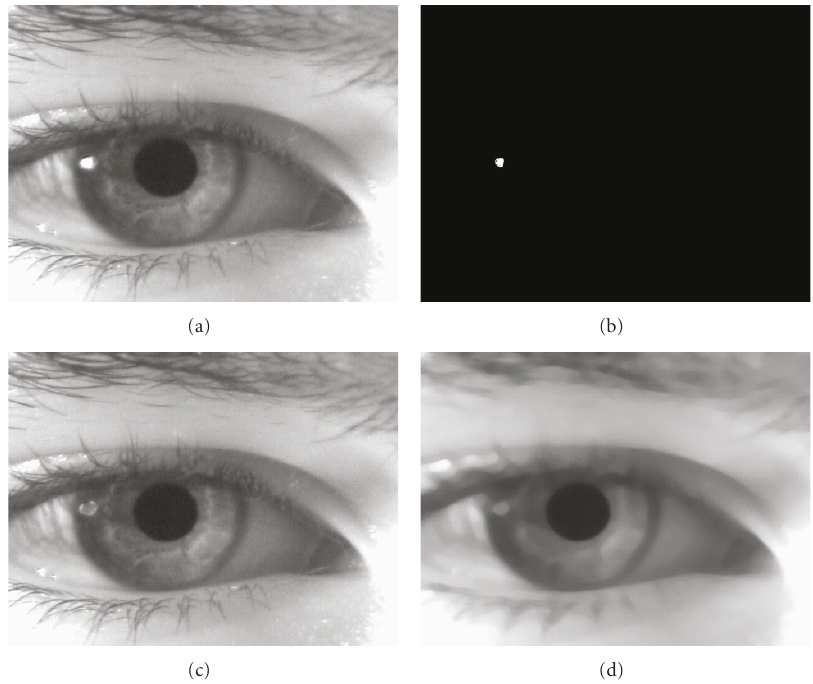
Figure 15: Here, we illustrate the steps to localize the limbic and pupillary boundaries. (a) shows the input eye image to be segmented. (b) shows the localization of the specularity present in the image. Intensity thresholding as well as geometrical constraints are used for this purpose. (c) shows the specularity filled with pixel values from the neighbourhood and finally (d) is the result of applying a median filter to (c). Intensity thresholding and geometric constraints help to localize the pupil in (d) following which we identify the pupillary and limbic boundaries as described in Section